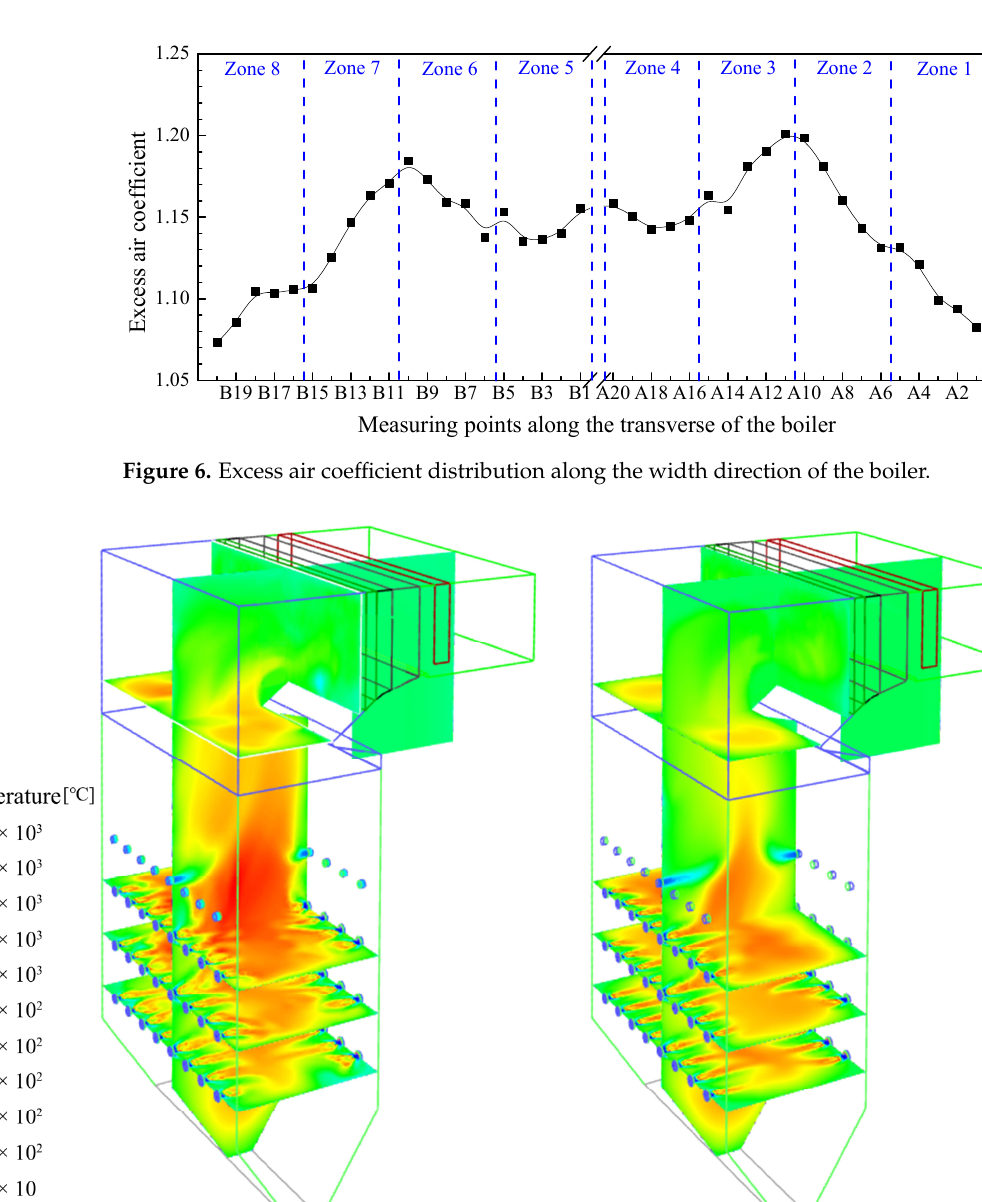
Figure 5. Numerical simulation results and design values of flue gas temperatures in different cross sections.